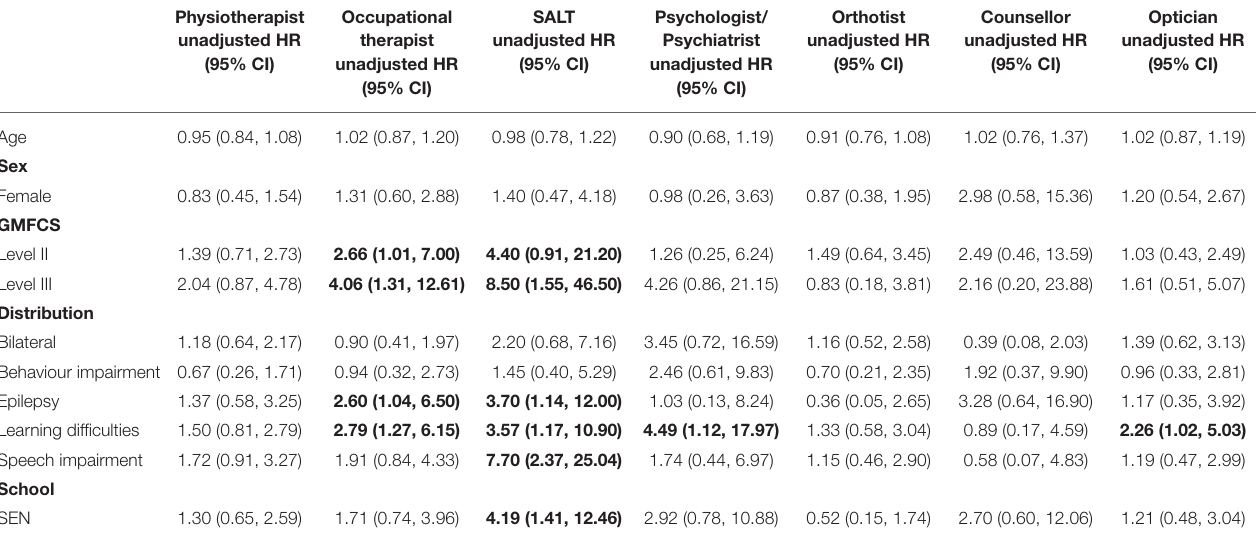
TABLE 3 | Unadjusted associations with at least one visit to a physiotherapist, occupational therapist, speech and language therapist, psychologist/psychiatrist, orthotist, counsellor, optician.